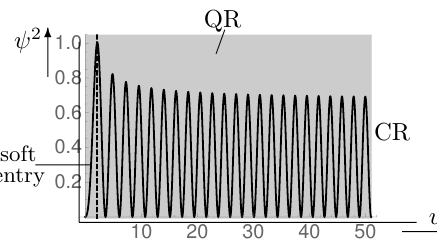
Figure 6. Square of our “soft entry” solution, extending from v = 0 to the dashed line, and at constant ρ = 1 continued over a larger v-interval. The upper boundary value should in reality be much